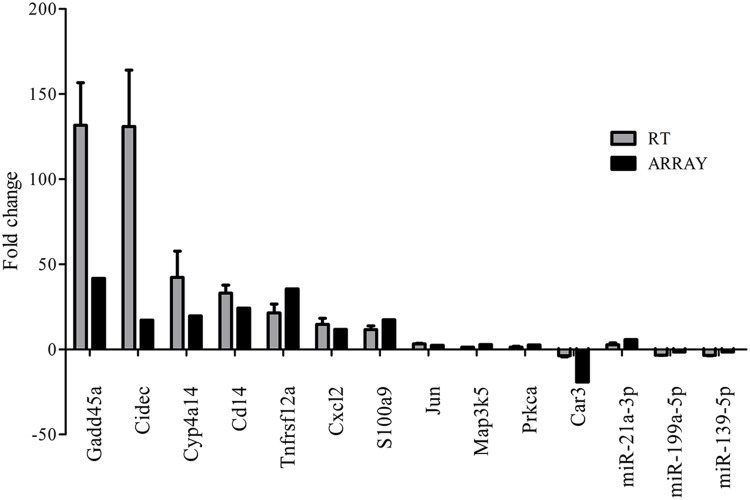
Validation of microarray results by real-time quantitative PCR. Gray bars (RT) indicate the mean fold change (±SD) derived from triplicate real-time quantitative PCR reactions (n = 5). Black bars (ARRAY) indicate microarray data.